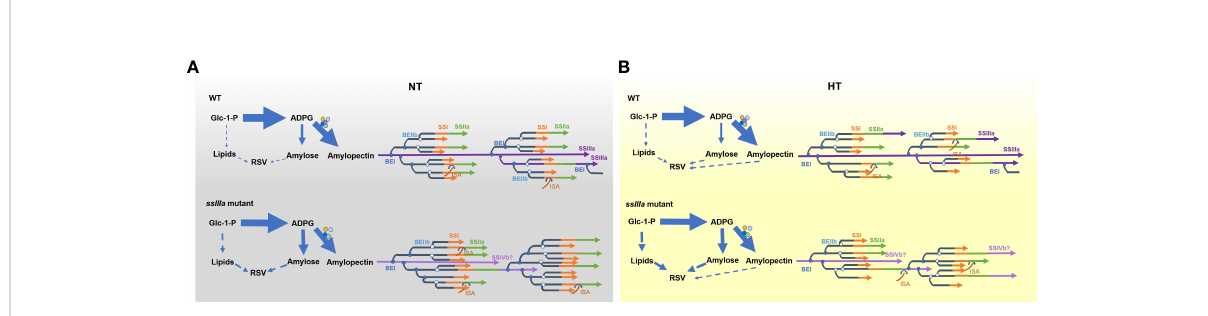
FIGURE 5 Proposed processes of RS formation in rice. (A) The loss-of-function mutation of SSIIIa causes repartition of carbohydrate, breaks the equibrium synthesis of amylose and amylopectin, and leads to higher AAC and lipid content that promote the formation of starch – lipid complexes. (B) Loss-of-function mutation of SSIIIa leads to more short chains of DP 9 – 15 both under NT and high temperature (HT). HT decreases the branching, resulting in less proportion of short chains and more long chains. The increased long chains and enhanced lipid content under HT stimulate more RS